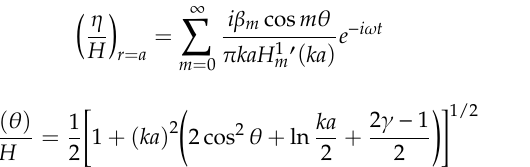
Figure 15. Time series of numerically simulated water surface elevation around the mono-pile.